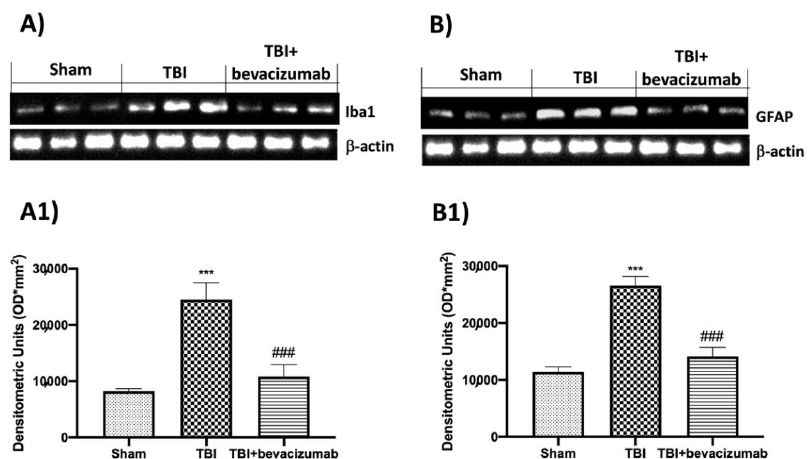
Figure 6. Effects of bevacizumab on Iba1 and GFAP 24 h after TBI. A remarkable increment in microglia and astrocytes activation was observed by Western blot analysis for Iba1 ( A , A1 ) and GFAP ( B , B1 ), respectively, in TBI-injured animals, compared to the Sham group ( A , A1 , B , B1 ). Treatment with bevacizumab reduced the activation of both microglia ( A , A1 ) and astrocytes ( B , B1 ). Data show one representative blot from three independent experiments with similar results. Data are expressed as mean ± SD from n = 5 mice/group. *** p < 0.001 vs. Sham; ### p < 0.001 vs. TBI .